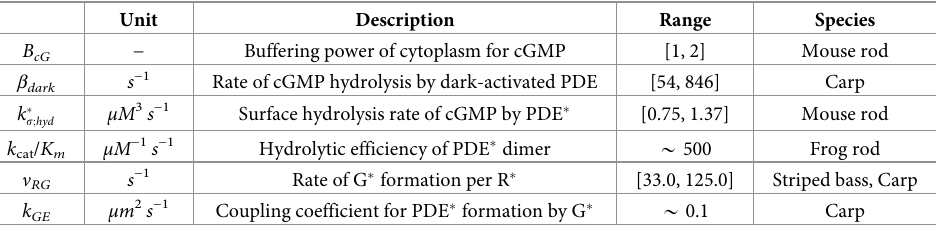
The ranges of B and k � for mouse rod are given above [3]. The parameter value for k / cat cG s ; hyd used by [33] in the analysis of striped bass cone was derived from measurements from frog K m rod [34]. N is Avogadro’s number. The PDE dark activity was reported as [0.3%, 4.7%] of Av the maximal PDE activity, 18 cGMP/ R � / s , in carp cone [14]. The dark rate of cGMP hydrolysis by PDE, β , was estimated by multiplying these factors by the concentration of R � in carp, dark [ cG ] . The value [cG] = 3 [R � ] = 3 mM [30], and then setting this resulting value to β dark dark dark ). μM was also taken (see Table 5 for a discussion of [cG] dark The activation rate ν was experimentally measured for carp in [31, 35] as ν � 33 s − 1 . RG RG Values for the rate of PDE activation by R � , estimated from modeling of striped bass and gold- fish cones [33, 36, 37], were considered in order to estimate the range for ν . Finally, the RG Table 3. Activation and hydrolysis